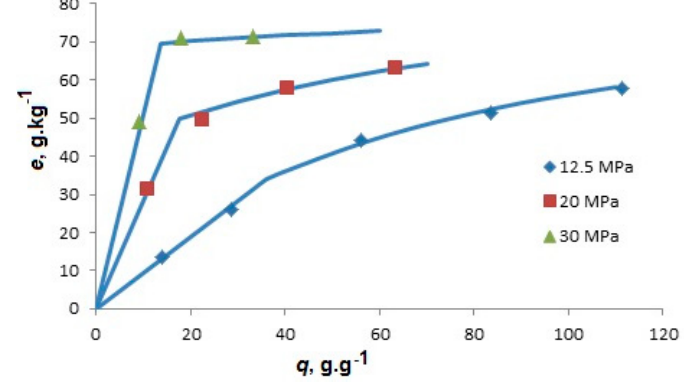
Figure 3. Yield of extracellular hydrocarbons from Botryococcus braunii [6] at 40 °C and q ’ = 0.39 g·min − 1 . The feed was N = 2 g.